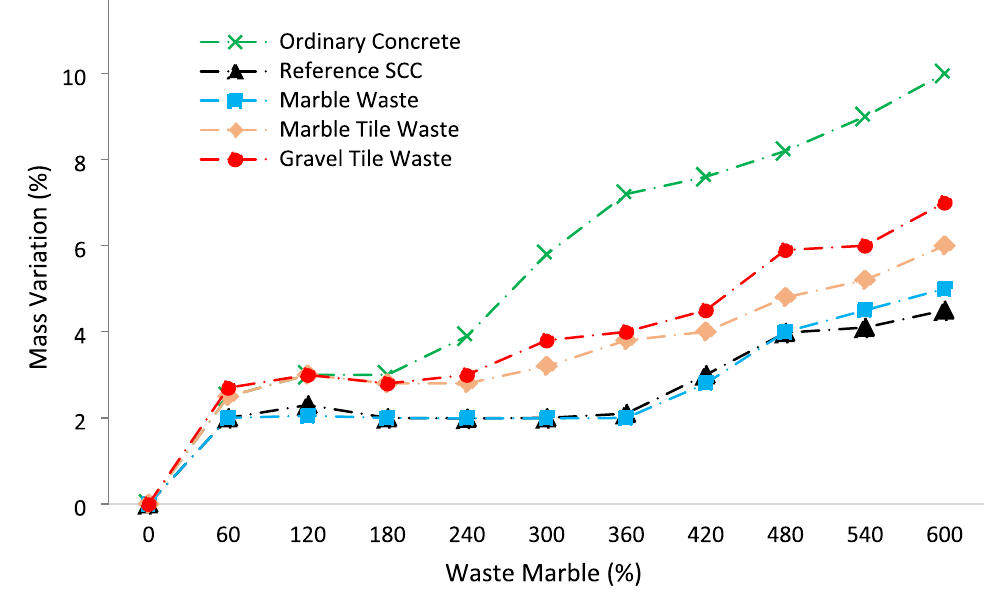
Fig. 18 Mass variation due sodium sulfate (Tennich et al.,